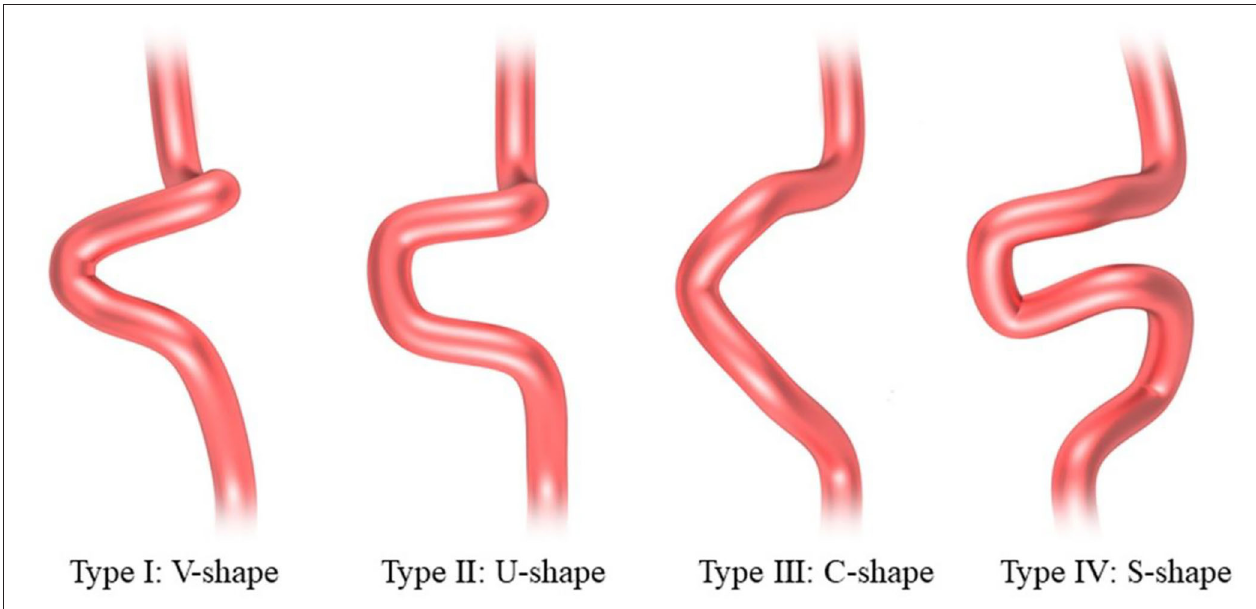
FIGURE 2 | Examples of carotid siphon internal carotid artery (ICA)